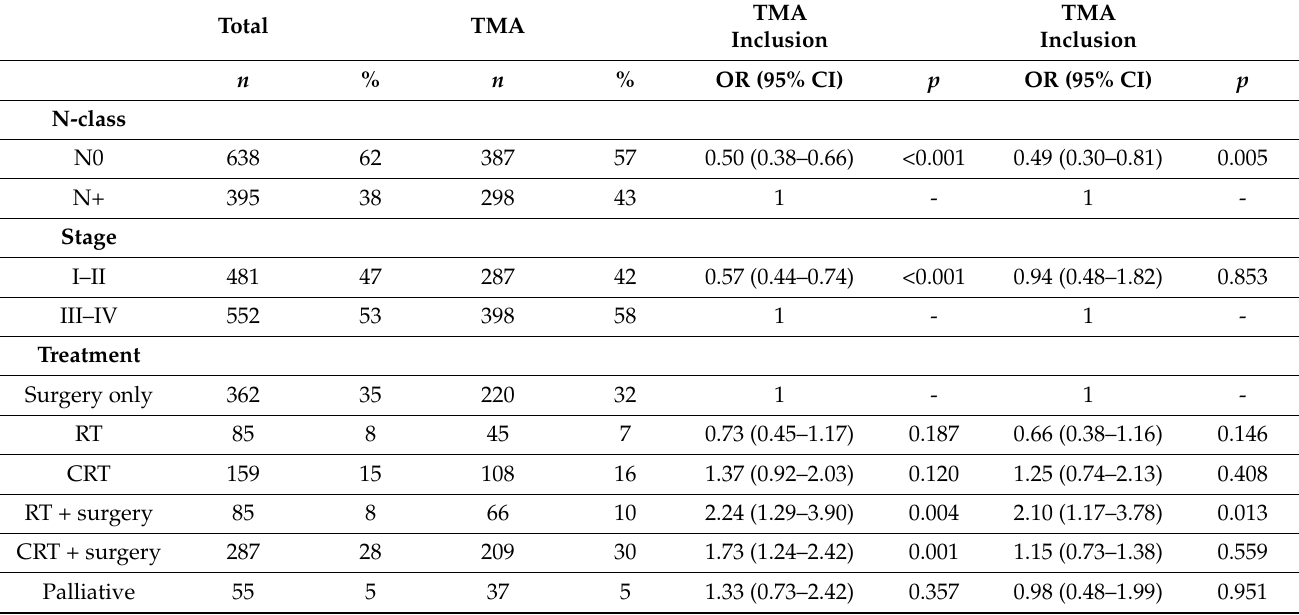
Table 4. p16 staining results by primary tumor location. The “other” group consisted of tumors of the nasal cavity, nasopharynx, sinuses, and tumors of unknown primary location.